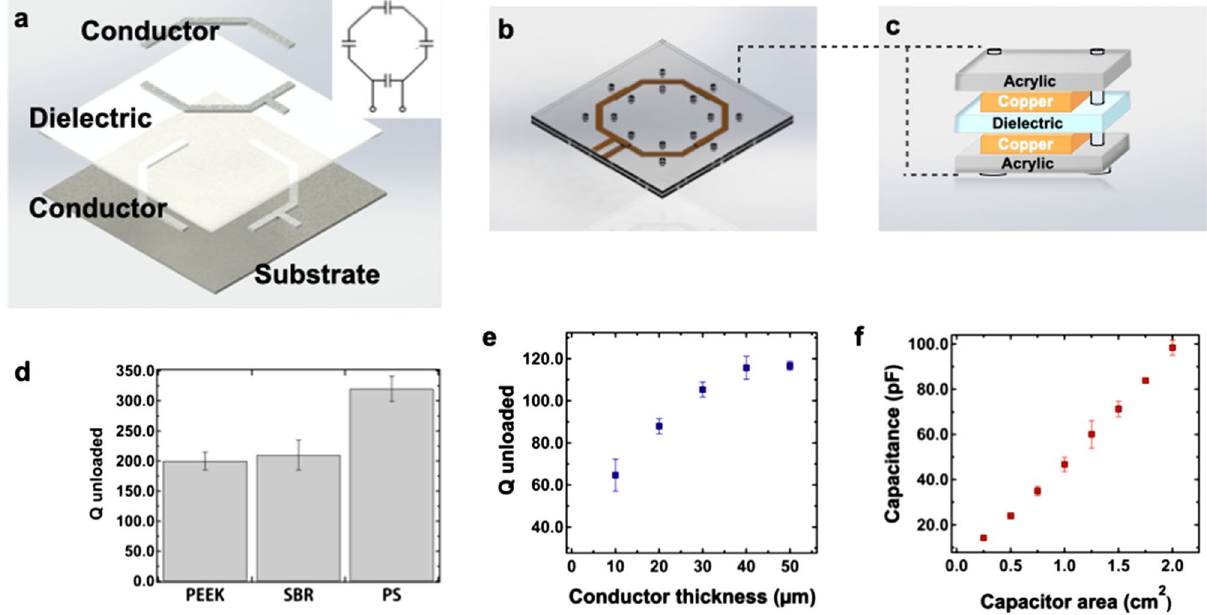
Figure 2. Characterization and optimization of coil components. ( a ) Schematic of the coil components that are sequentially deposited into the substrate. The conductor traces are designed to overlap, forming coils with capacitors evenly spaced throughout the loop. Schematics of the top view ( b ) and cross section ( c ) of the custom setup used to characterize dielectric properties of the candidate materials. Dielectric films are spray- deposited onto the copper traces fabricated from the commercial foil. The copper coils are clamped together with the dielectric in between using two acrylic sheets. ( d ) Q unloaded of the styrene butadiene resin (SBR) and polystyrene (PS) dielectric films sprayed from the solution, and commercially available polyether ether ketone (PEEK) film. ( e ) Effect of conductor thickness on the Q unloaded. ( f ) Dependence of capacitance on the top electrode